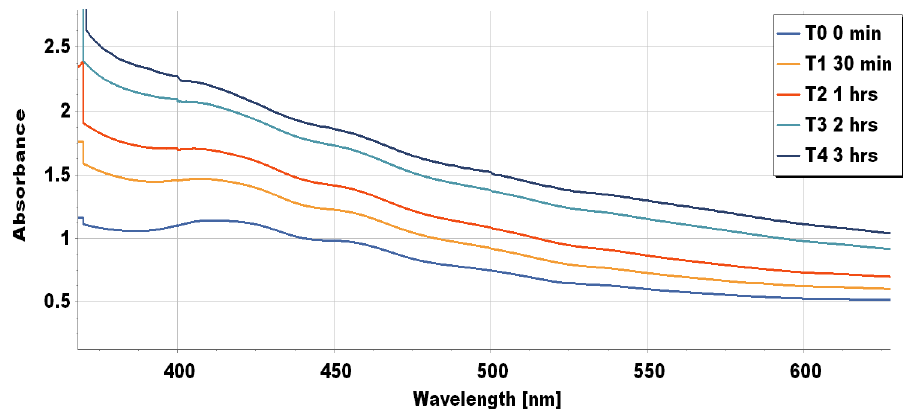
Figure 1. The presence of an absorbance peak around 420 nm clearly indicates the formation of OSM-AgNPs in the solution, while the intensity of the SPR band increased with reaction time, indicating the formation of the nanoparticles.